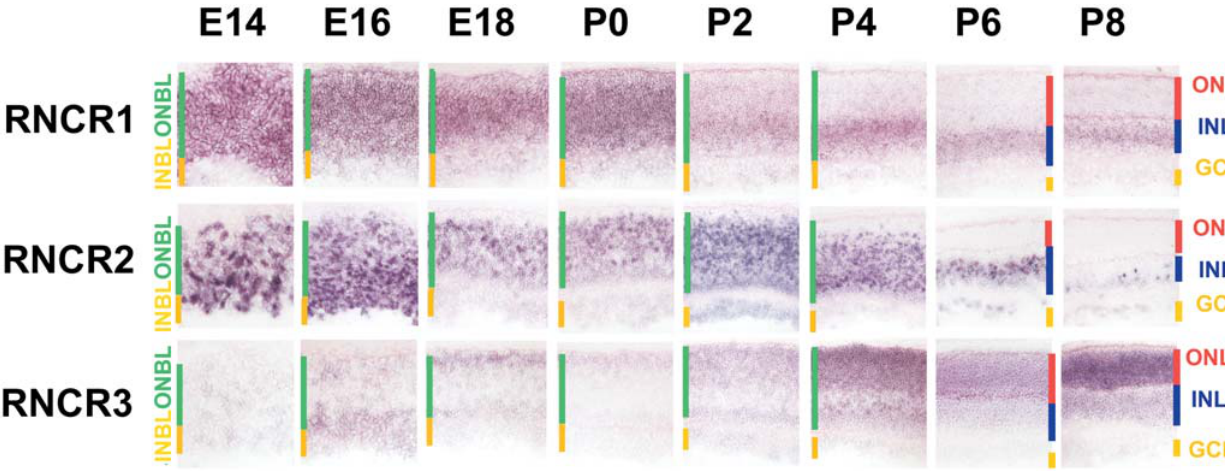
Figure 6. Noncoding RNAs in Retinal Development A number of presumptive noncoding RNAs are strongly expressed in dynamic subsets of retinal progenitor and precursor cells. The transcripts shown are Mm.150838/ RNCR1, Mm.44854/ RNCR2, and Mm.194050/RNCR3 . Sections were from central retina. Cellular laminae of both the developing and mature retina are indicated with colored bars. All pictures were taken at 200x. See Table S5 for a full list of probes used. DOI: